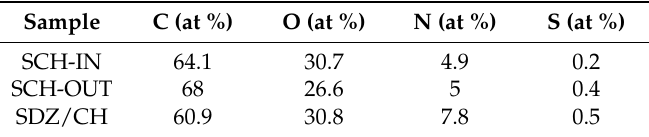
Table 3. Atomic elemental composition of studied samples.